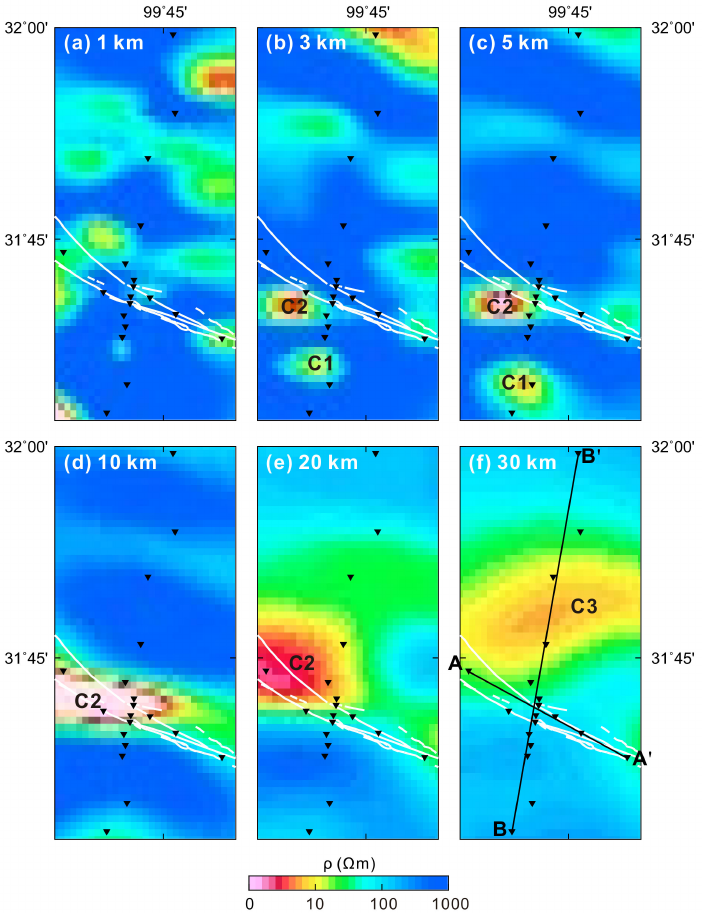
Figure 7. The final model at representative depth slices. The black triangles denote the MT sites, and the white lines denote active faults. The black lines denote MT profiles in Figure 9. The conductive anomalies (C1–C3) are discussed in this paper.